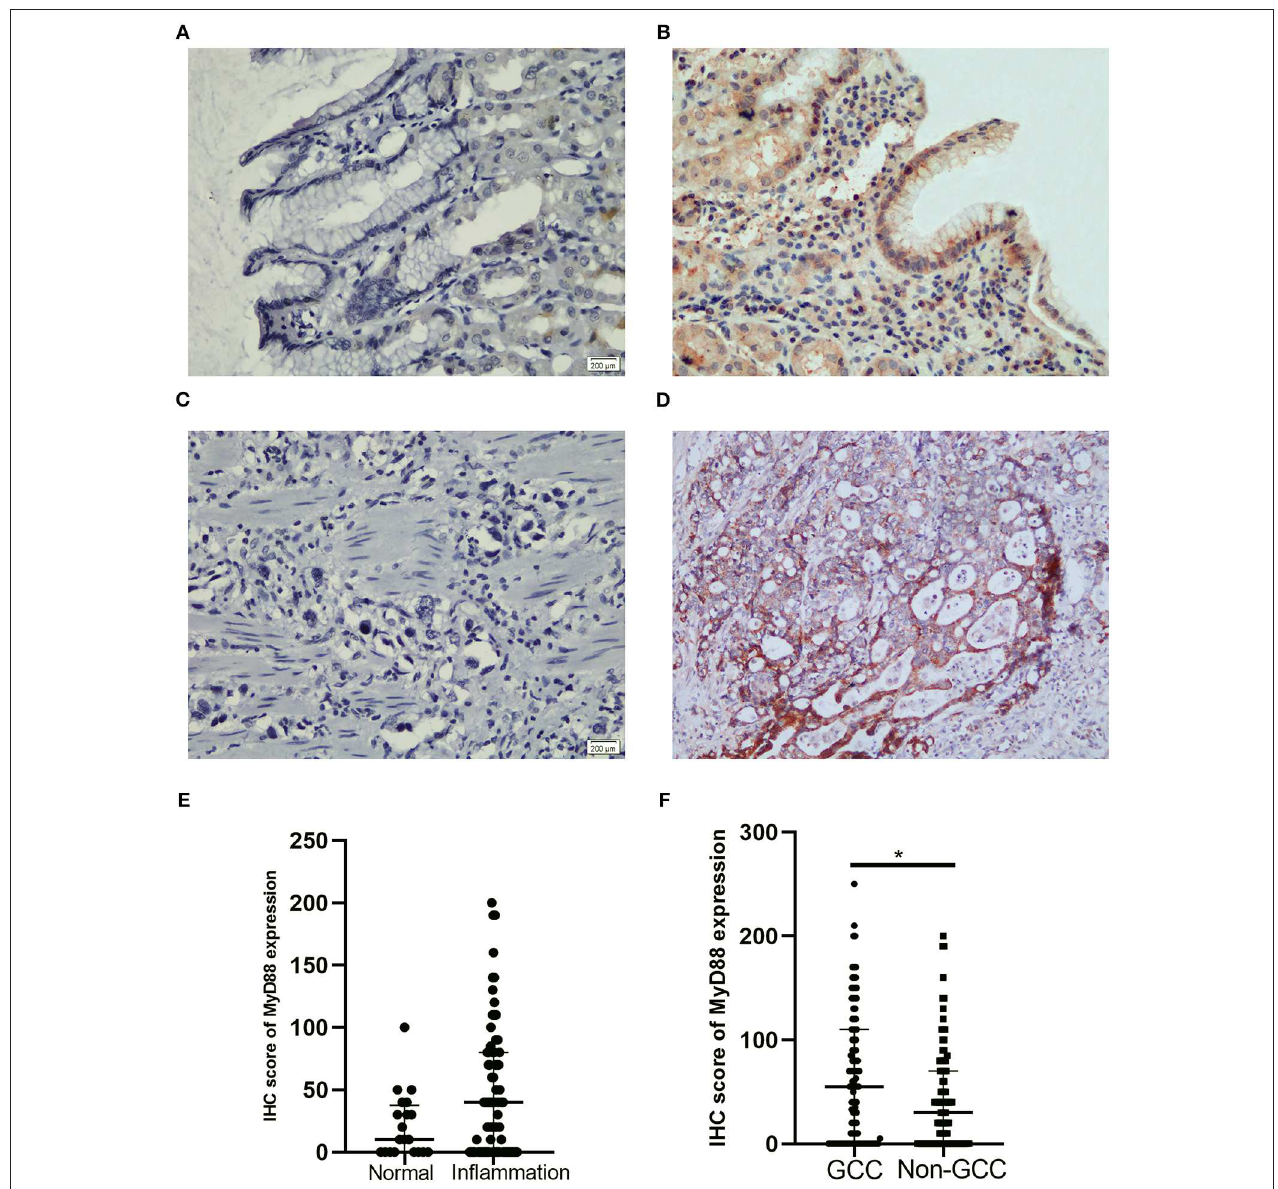
FIGURE 1 | Representative IHC staining for MyD88 in gastric cardia mucosae and gastric cardia cancer tissue. (A) No immunostaining in normal mucosae, (B) moderate positive staining in mucosae with inflammation, (C) negative MyD88 staining in poorly differentiated tumor, and (D) strong positive staining in intestinal-type adenocarcinoma. (E) Boxplot shows MyD88 expression was higher in the inflammation cases than normal tissues. (F) Boxplot shows MyD88 expression was significantly higher in the GCC cases compared to the non-malignant cases (*p <